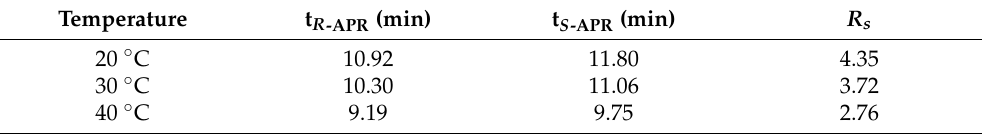
Table 1. Effects of the temperature on migration times of the analytes and enantioresolution. Temperature t R -APR (min)